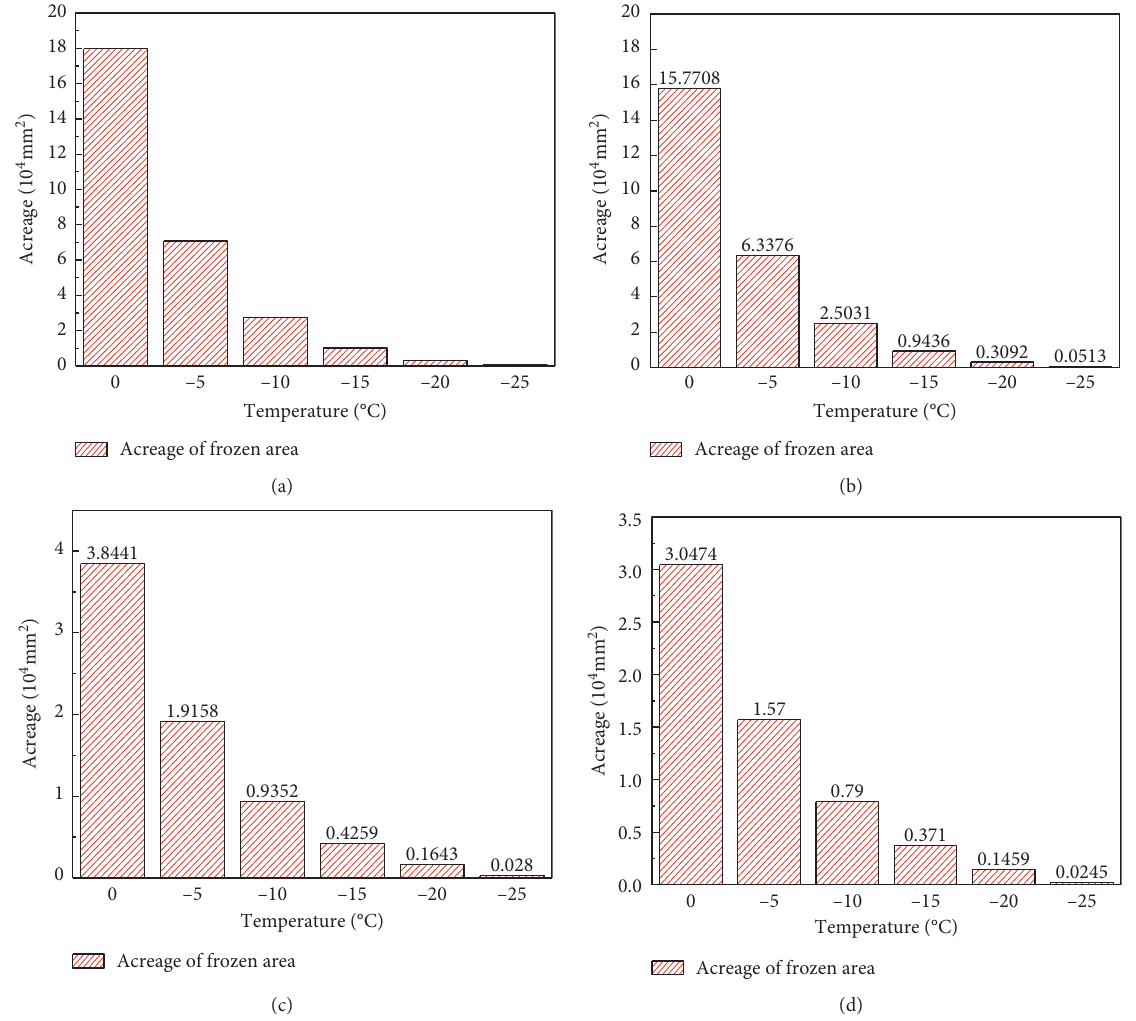
Figure 8: Frozen area surrounded by isotherms at different temperatures under the action of seepage field with a flow rate of (a) 0, (b) 3, (c) 6, and (d) 9